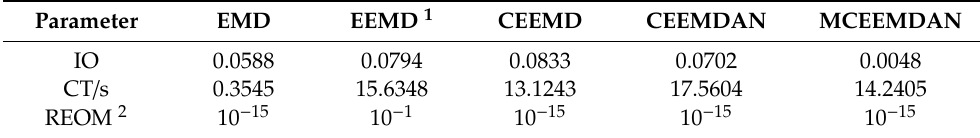
( c ) Figure 5. Entropy values of noisy simulated signals. ( a ) sample entropy (SE); ( b ) permutation entropy (PE); and ( c ) dispersion entropy (DE). Table 2. Consuming time of different entropy algorithms. SE